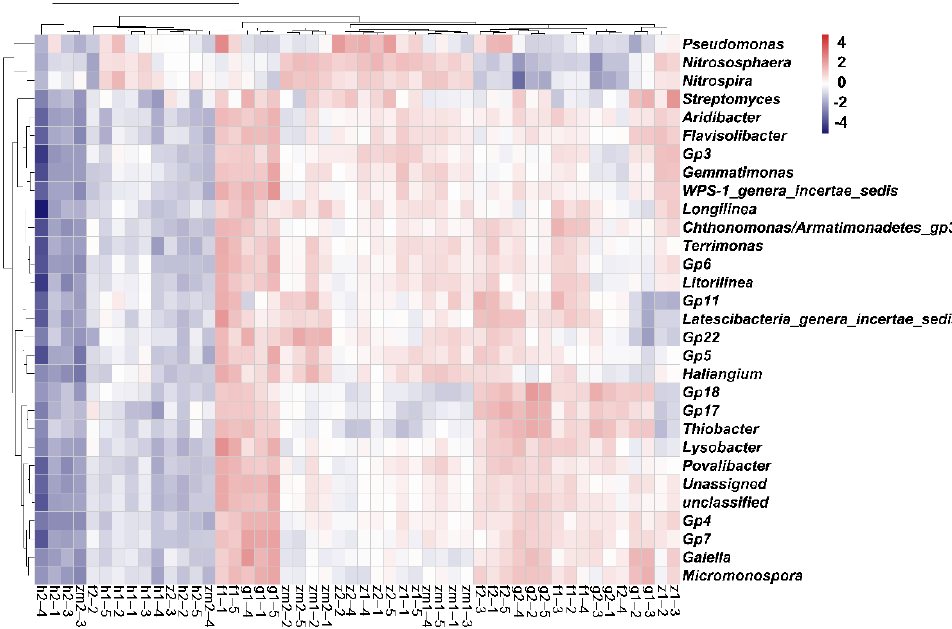
Figure 5. The heatmap of the distributions of the 30 richest bacterial genera at 0 – 20 cm soil depth and 20 – 40 cm soil depth. The absolute abundances of bacterial genera in soil are indicated by color intensity. g1: grass land at 0 – 20 cm; g2: grass land at 20 – 40 cm; f1: secondary forest land at 0 – 20 cm; f2: secondary forest land at 20 – 40 cm; z1: Zanthoxylum planispinum land at 0 – 20 cm; z2: Zanthoxylum planispinum land at 20 – 40 cm; h1: Hylocereus spp. land at 0 – 20 cm; h2: Hylocereus spp. land at 20 – 40 cm; zm1: Zea mays land at 0 – 20 cm; zm2: Zea mays land at 0 – 20 cm.